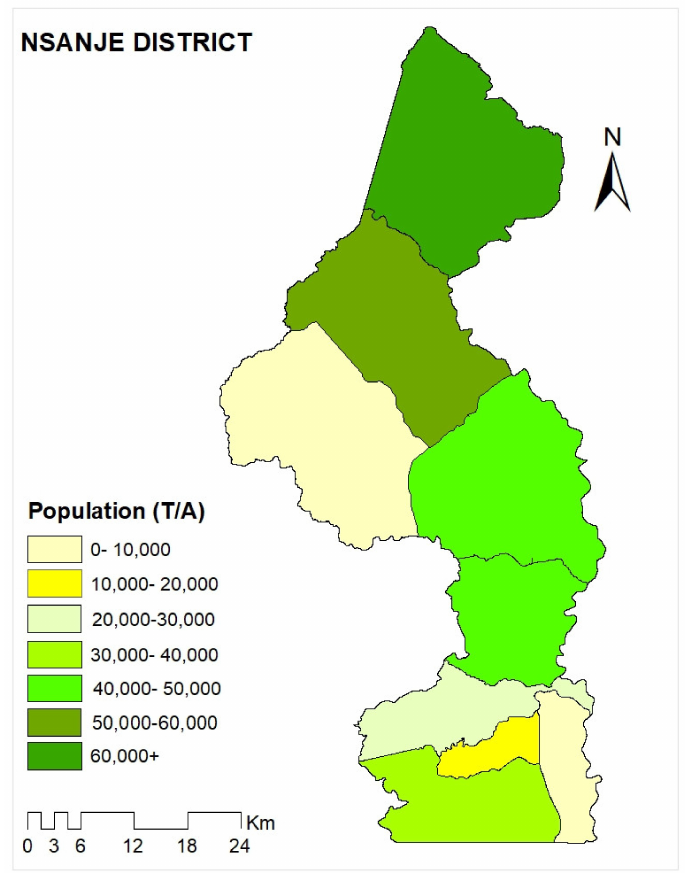
Figure 1. Map of